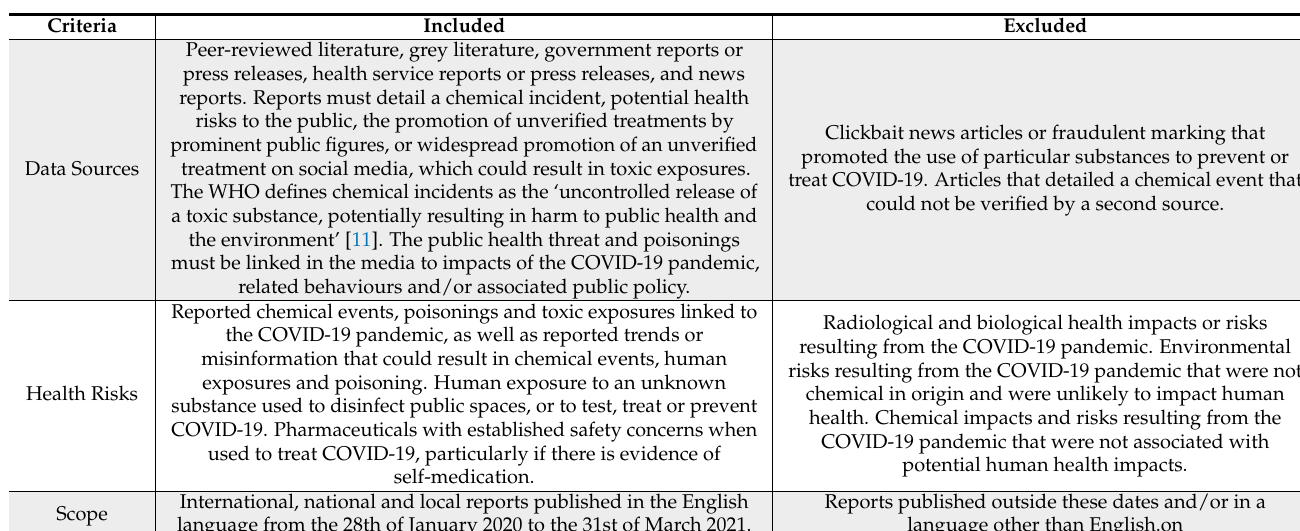
Table 1. Inclusion and exclusion